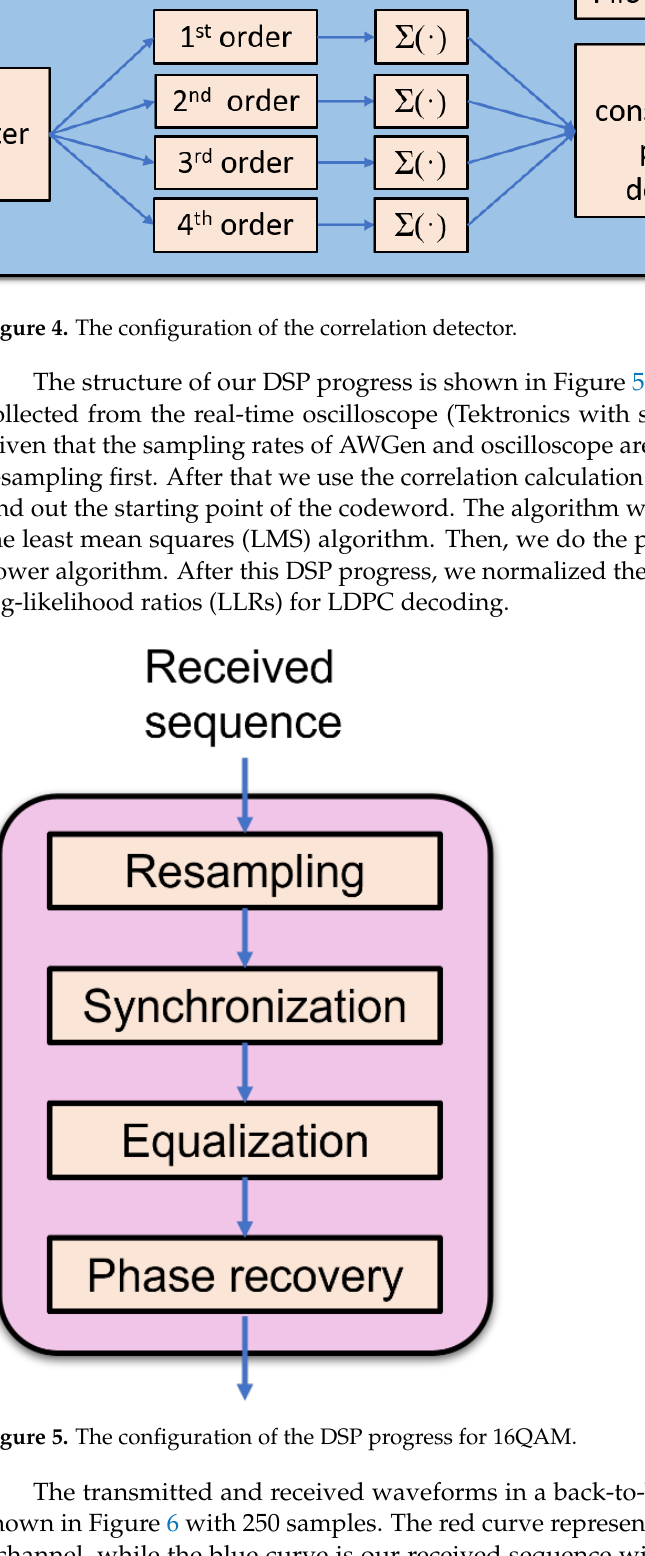
Figure 5. The configuration of the DSP progress for 16QAM.